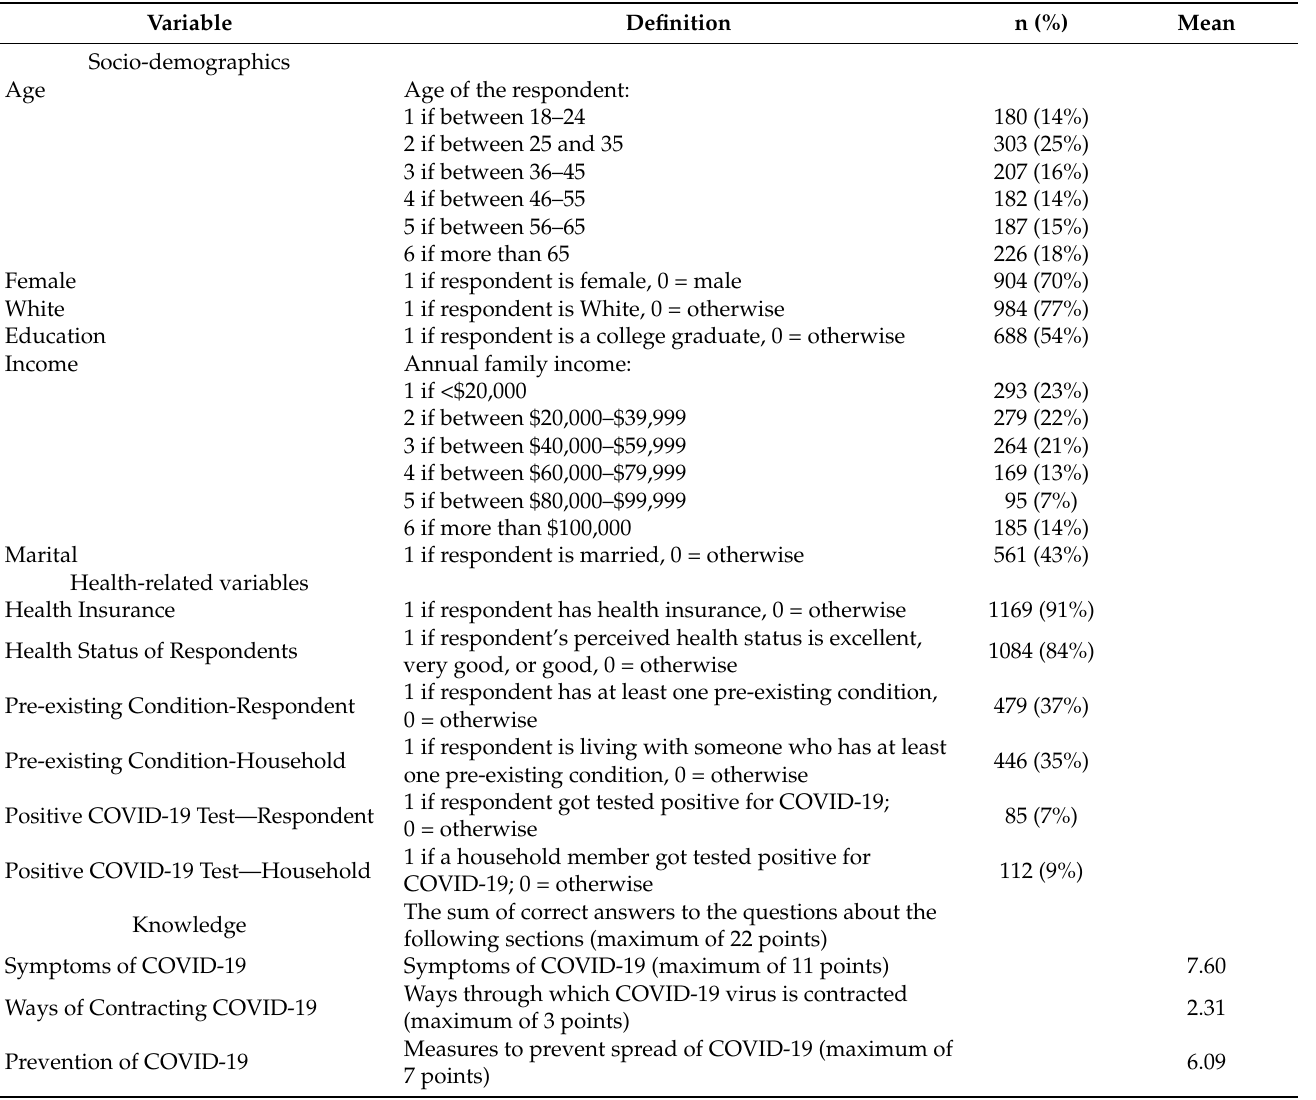
Table 2. Variable definitions and descriptive statistics ( N =